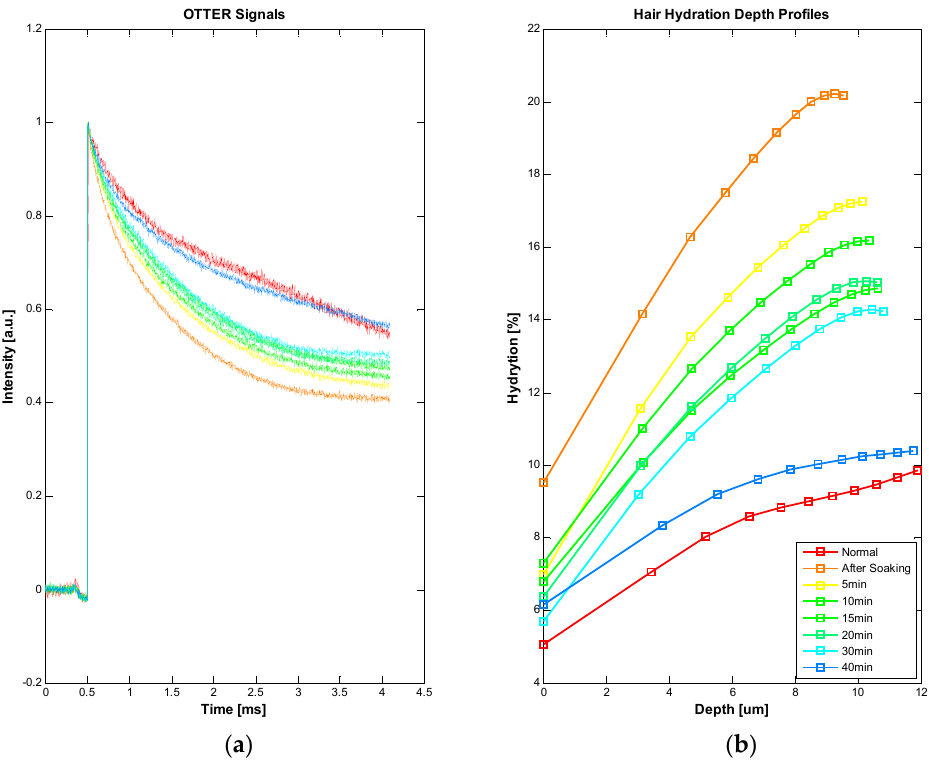
Figure9. OTTER signals of ex vivo human hair ( a ), and corresponding water concentration depth profiles in hair before and after soaking ( b ).